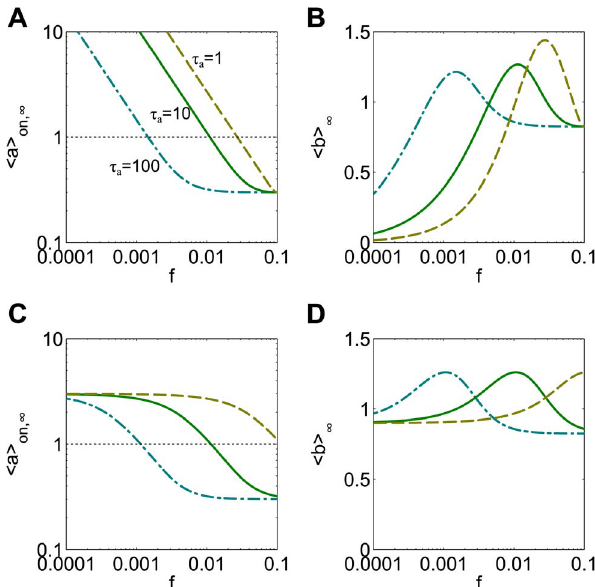
Figure 9. The kinetics of the linear component affect the peak frequency of a bell shaped response. The production rate function is F(a)=a 2 /(a 2 + K 2 ) with K=1. ( A ) Amplitude compensation: when the time constant of variable a is increased to t a =100 (teal dash-dotted curve) or decreased to t a =1 (tan dashed curve) from the default value of t a =10, the frequency at which , a . on, ‘ crosses K=1 shifts to the left or right, respectively. ( B ) The corresponding bell-shaped responses have a peak that shifts to the right accordingly. ( C ) Duration compensation: increasing t a shifts the response in , a . on, ‘ and its K crossing point to the right. The fastest system (tan dashed curve) no longer crosses K in the frequency range examined. ( D ) The bell-shaped response shifts to the right accordingly, and , b . b is a strictly increasing response in the frequency range examined. A 0 =3 and d 0 =10 at frequency f 0 =0.01.